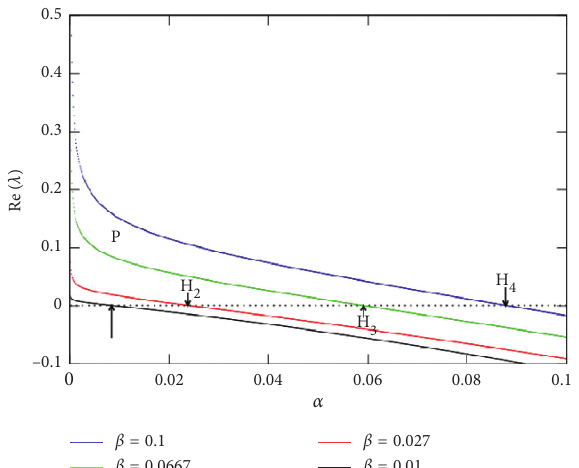
Figure 1: Real part of the eigenvalues versus α for different values of β . H